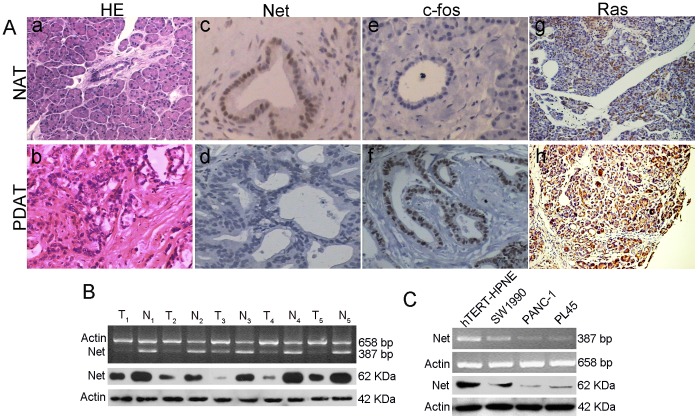
Net is down-regulated in pancreatic ductal adenocarcinoma.(A) Immunohistochemical analysis of Net, c-fos and Ras expression in pancreatic ductal adenocarcinoma tissues (top row) and matched adjacent normal tissue samples (bottom row). a and b is H&E staining with low resolution (×100); c, d denote the expression of Net representative with high resolution (×200); e, f denote the expression of c-fos representative with high resolution (×200); g, h denote the expression of Ras representative with high resolution (×200). (B) Expression of Net was examined at mRNA and protein levels using RT-PCR and western blotting on human pancreatic ductal adenocarcinoma tissues (T) and matched adjacent normal tissue samples (N) (presentive 5 cases of 36). (C) Expression of Net was examined at mRNA and protein levels using RT-PCR and western blotting in pancreatic cancer cell lines (SW1990, PANC-1 and PL45) and human pancreatic cell hTERT-HPNE. PDAT, pancreatic ductal adenocarcinoma tissues; NAT, normal adjacent tissue.